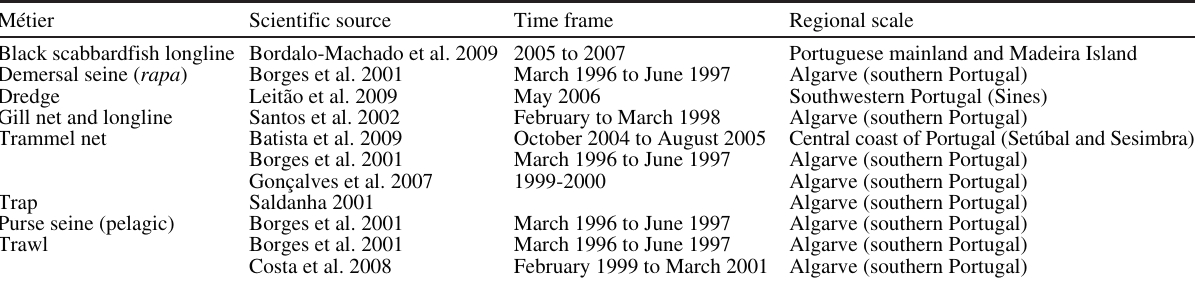
Table 1. – Studies with discard rates used to estimate the discards (unreported catches) per métier and per taxa.